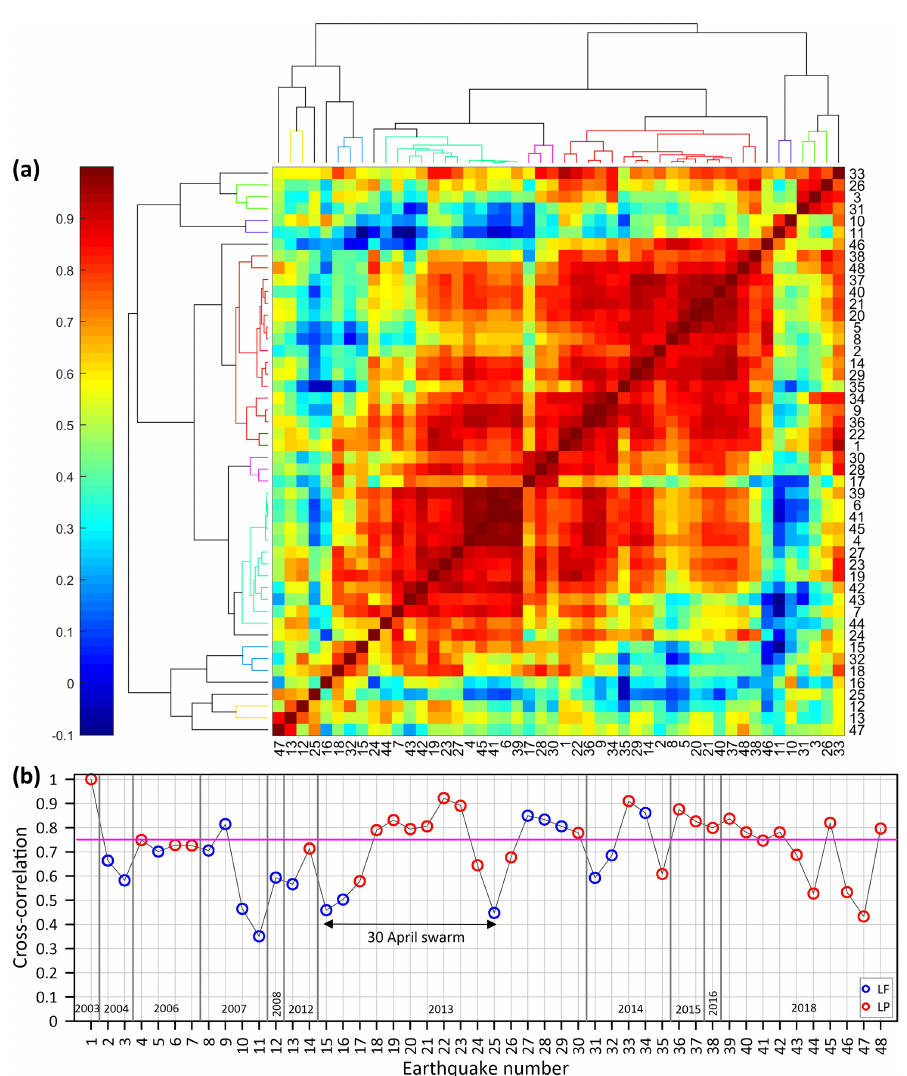
Figure 5. (a) Correlation matrix ordered according to the hierarchical clustering: each earthquake is indicated by a number assigned in a chronological order (LP03 = 1). The coloured branches of the dendrogram (hierarchical cluster tree) correspond to correlation values greater than 0.75; their height is a measure of the correlation between two events or clusters. (b) Cross correlation with LP03. Vertical grey lines mark the different years. The threshold of 0.75 for the maximum of the cross-correlation function is marked by the horizontal magenta line. The events are classified into LF (blue circles) and LP (red circles) according to the γ value of the high frequency spectral